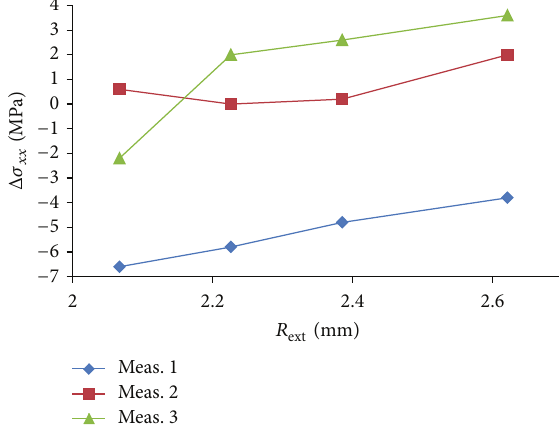
Figure 4: Plot of the average stress measured along the drilled depth in correspondence with different values of 𝑅 constant the value of the internal radius ratio 𝑅 int = 1.59 mm. The three curves refer to three different holes in the same specimen under the same stress